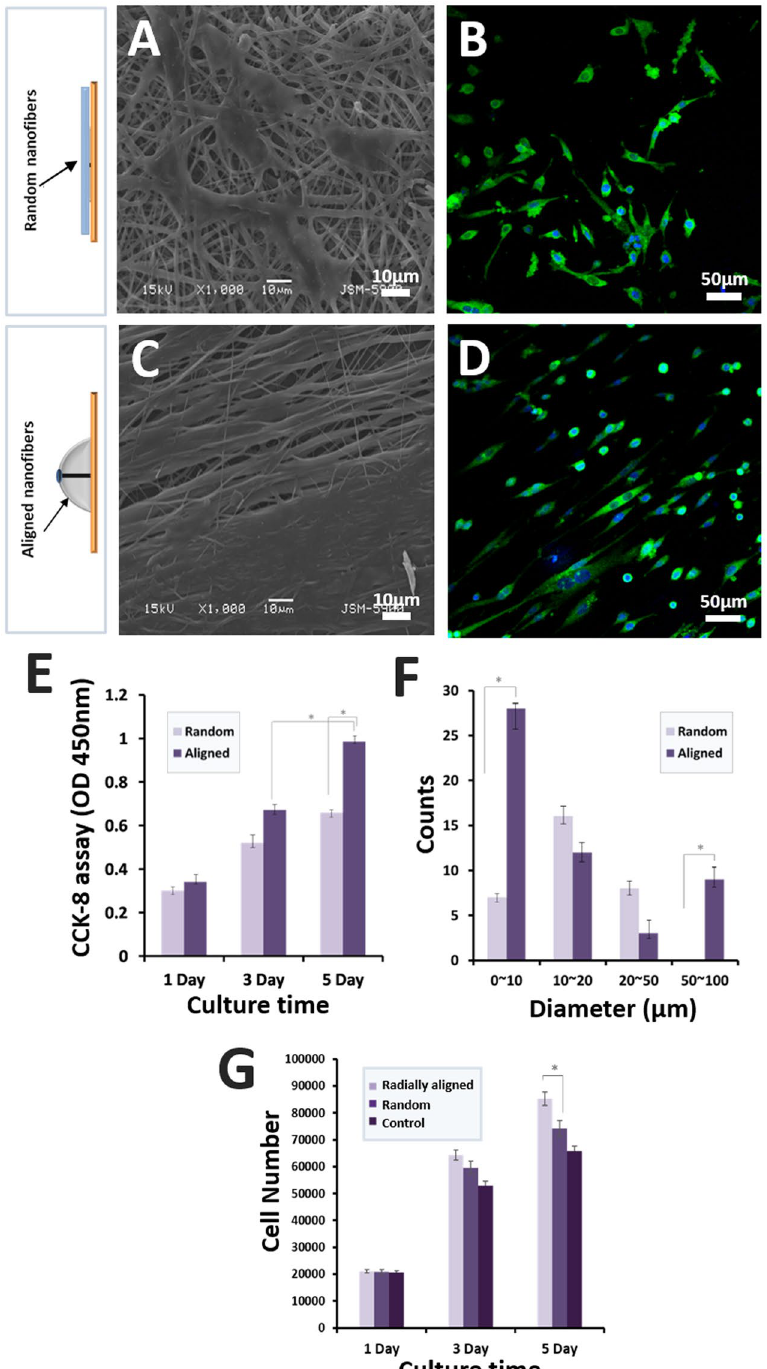
Figure 6. ( A ) SEM image of corneal cells of a rabbit attached after 3 days of culture on a randomly oriented nanofibrous mat. ( B ) Confocal microscopy images of corneal cells of a rabbit attached after 3 days of culture on a randomly oriented and aligned nanofibrous mat. ( C ) SEM image of corneal cells of a rabbit attached after 3 days of culture on an aligned nanofibrous mat. ( D ) Confocal microscopy images of corneal cells of a rabbit attached after 3 days of culture on an aligned nanofibrous mat. Actin Green 488 (green) was applied for actin filament and DAPI (blue) for staining nuclei. ( E ) CCK-8 assay result of corneal cells of rabbit on random and radially aligned nanofibrous mats after 1, 3, and 5 days of cell culture. ( F ) Distribution of cell size for corneal cells of a rabbit attached after 3 days of culture on randomly oriented and aligned nanofibrous mats. ( G ) Pico Green dsDNA quantification